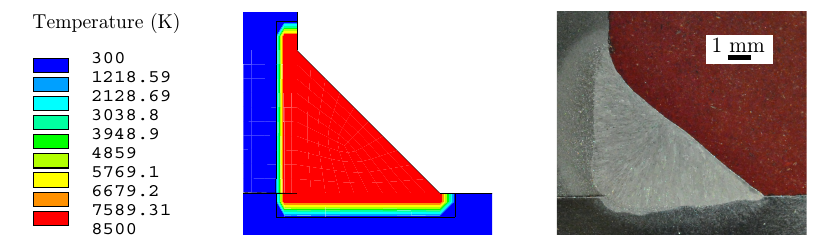
Figure 4. Activated elements for the constant initial temperature (CIT) model with a temperature of T i ( left ) cross section of the weld seam ( right